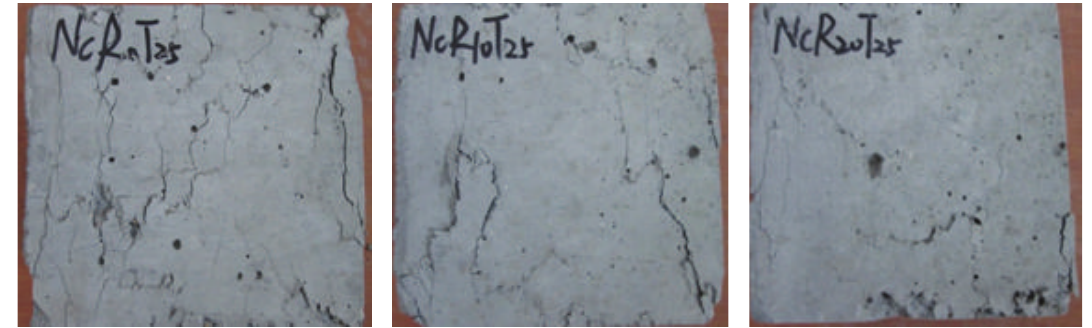
Figure 11: Actual measured fracture distribution in rubber